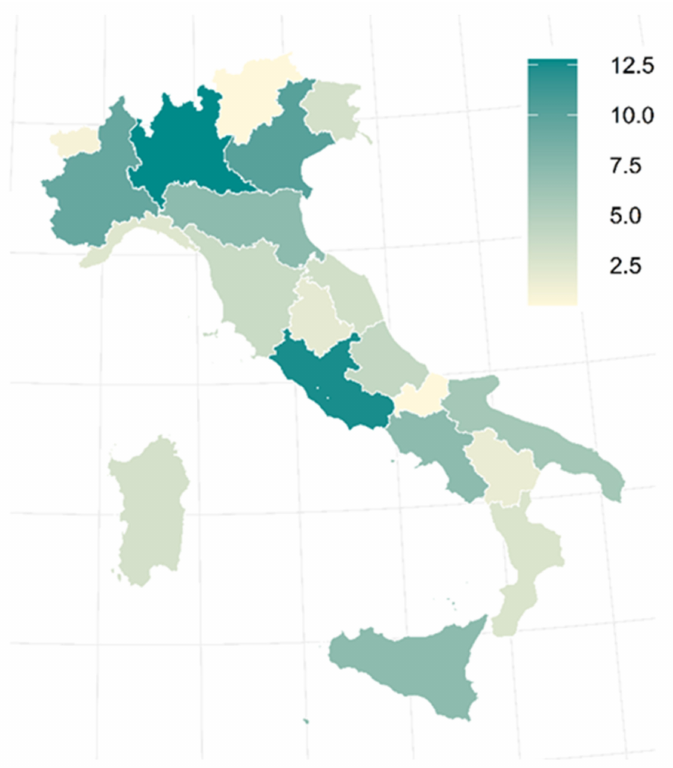
Figure 1. Regional distribution of cancer pain therapists. The color intensity expresses the percentage of respondents of each region.